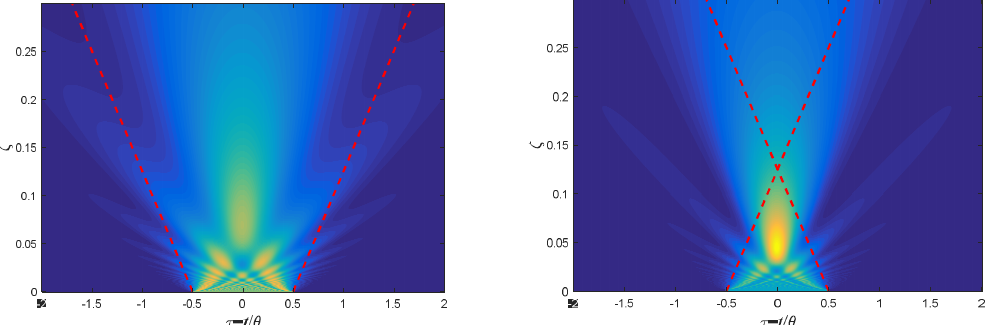
  2 , ztA Figure 8. Same as Figure 2, but for the intensity ( | A ( t , z ) | 2 ) of the pulse presented by Equation (31). Figure 8. Same as Figure 2, but for the intensity ( ) of the pulse presented by Equation (31). On the left, q = 4/ θ 2 ; and on the right, q = − 4/ θ 2 . The dashed lines correspond to the pulse’s On the left, 2 /4  q ; and on the right, 2 /4  q . The dashed lines correspond to the pulse’s boundaries t B = ± θ ( 1 + 2 β 2 qz )   2/21  . qzt boundaries 2 B